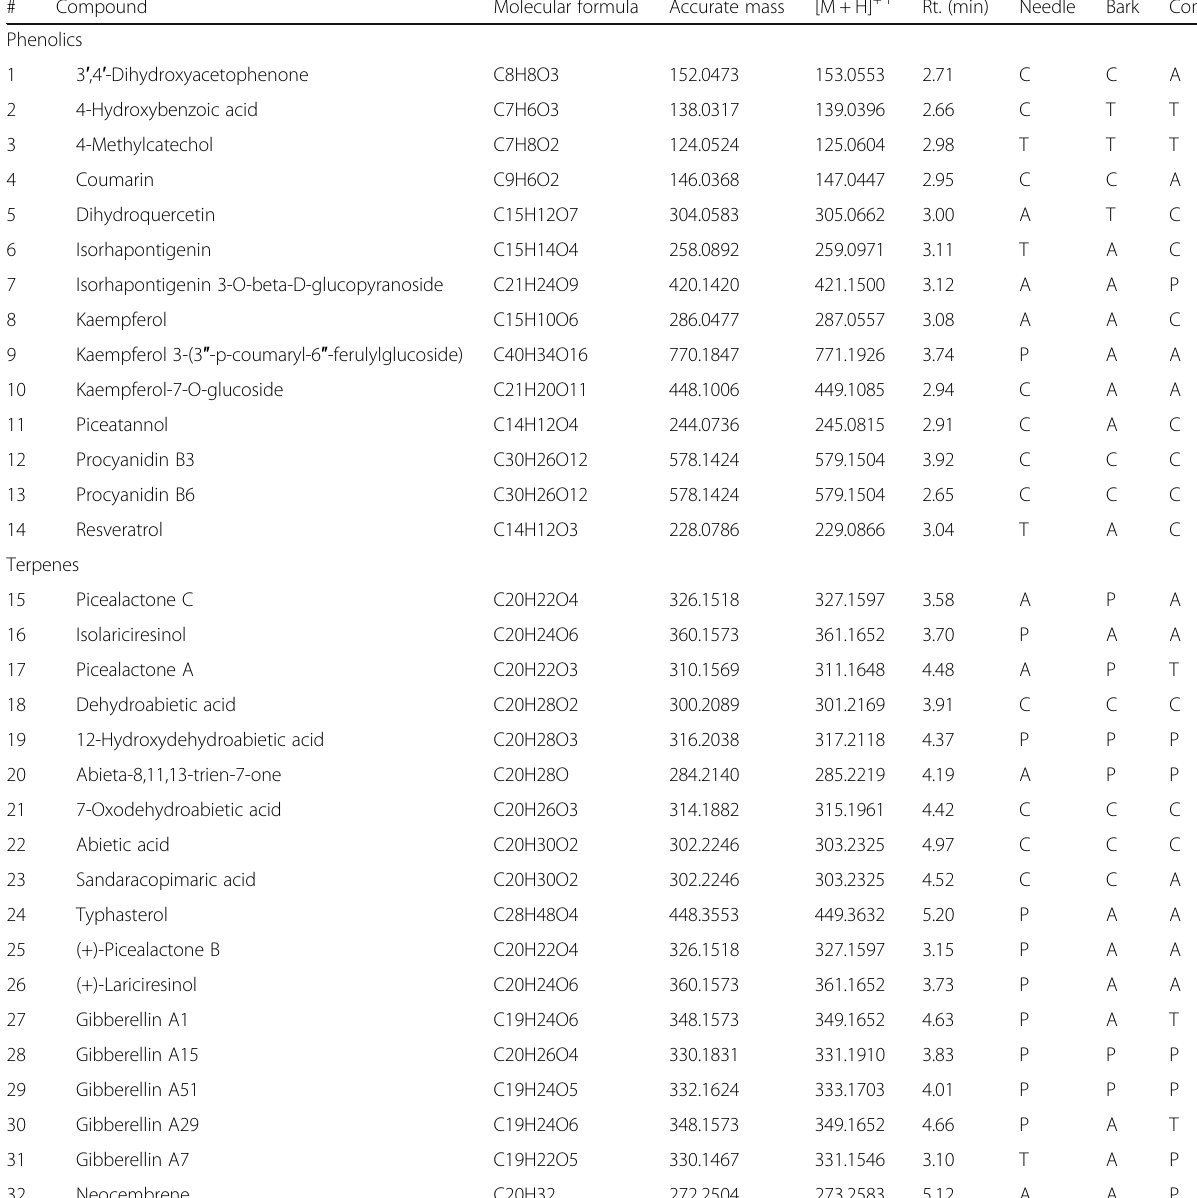
Table 4 List of compounds in P. mariana needle, bark and cone extracts identified by ESI-QTOF positive electrospray ionization. C (Retention time match ±0.02 min, low and high energy spectra match within ±5 ppm mass accuracy); P (low and high